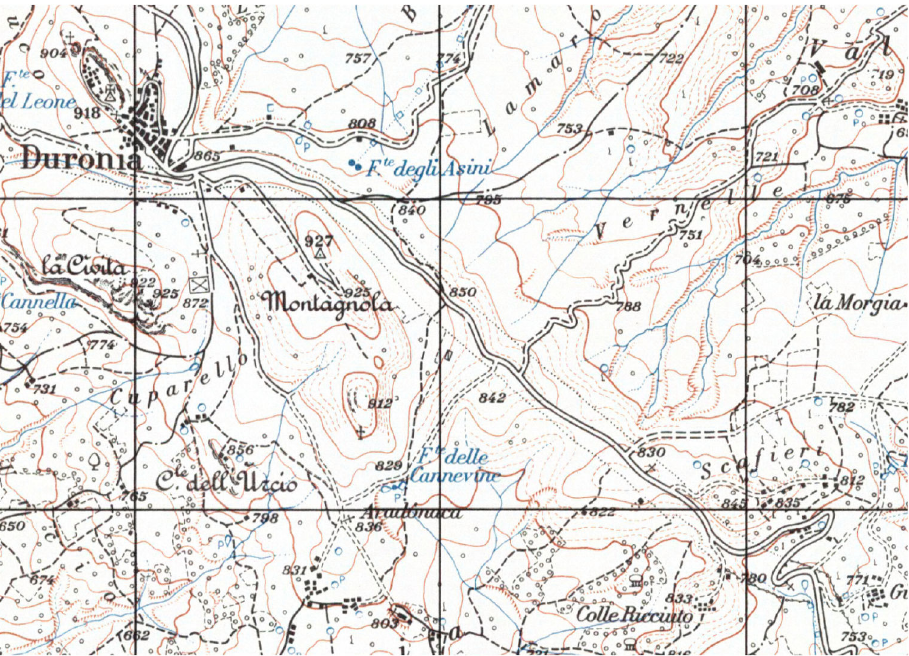
Figure A4. Details of IGM tablets. As reported in Figure A2, the Tratturo Castel di Sangro-Lucera is represented with two dotted lines. It is possible to notice its narrowing nearby the residential area of Duronia and the presence of an ordinary road, nowadays named Provincial Street 46. Authorization to publish n. 6959 of 2017.10.03 granted by Istituto Geografico Militare Italiano